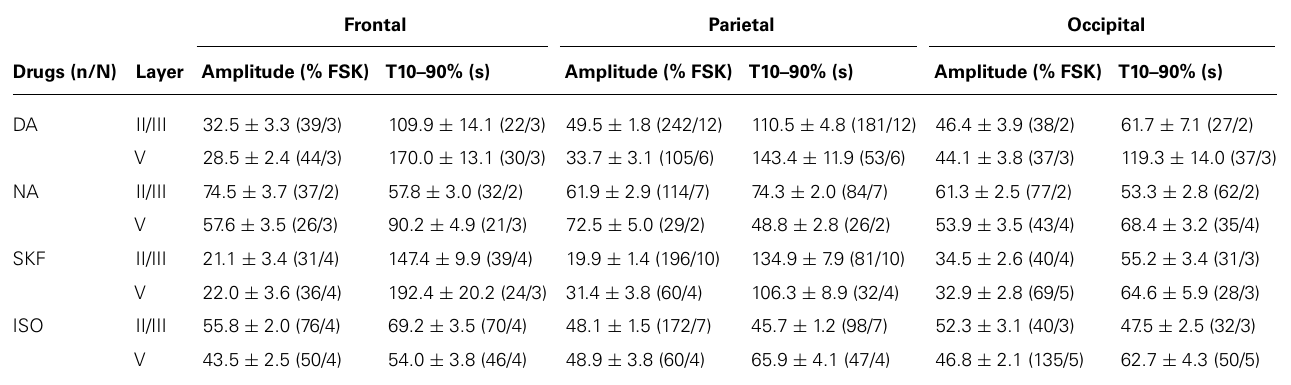
Table 1 | NA and DA activate PKA across cortical region and layers. Frontal